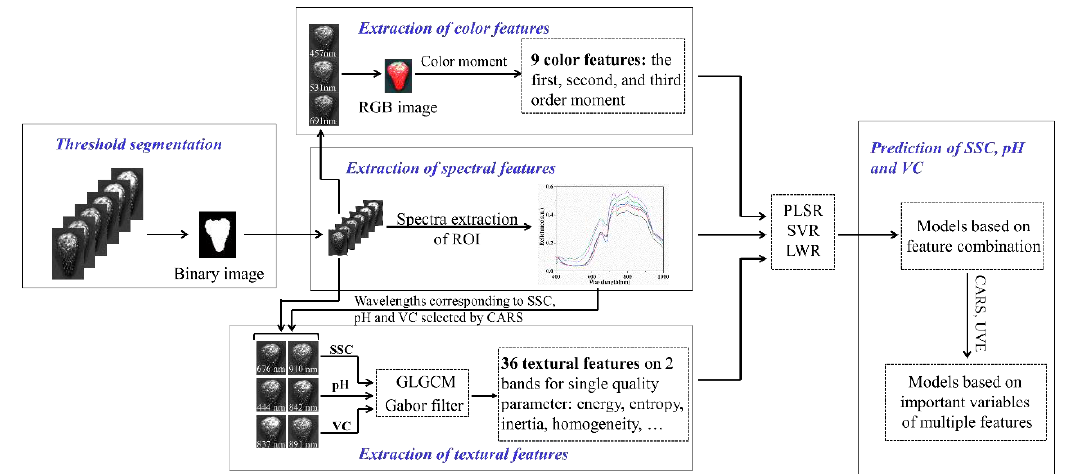
Figure 1. Flow diagram of prediction of soluble solid content (SSC), pH, and vitamin C (VC) of strawberries with multiple features. Partial least-squares regression (PLSR), support vector regression (SVR), locally weighted regression (LWR), gray level-gradient co-occurrence matrix (GLGCM), region of interest (ROI), competitive adaptive reweighted sampling (CARS) and uninformative variable elimination (UVE).